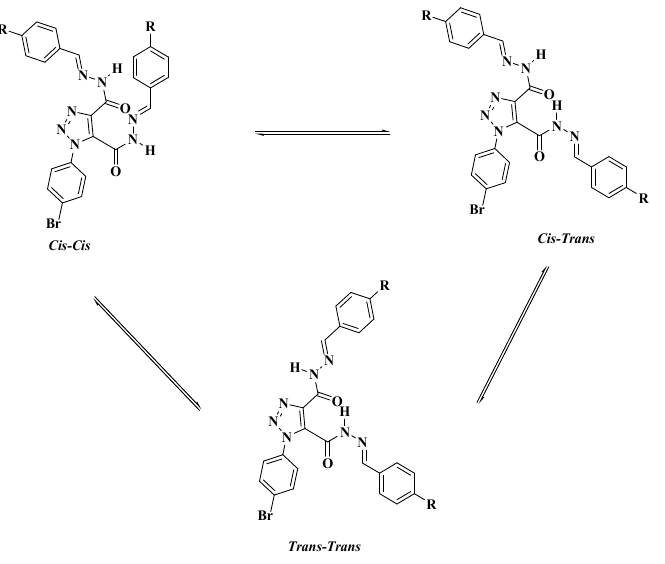
Scheme 3. Possible conformational isomers for diacidhydrazones 5a – g